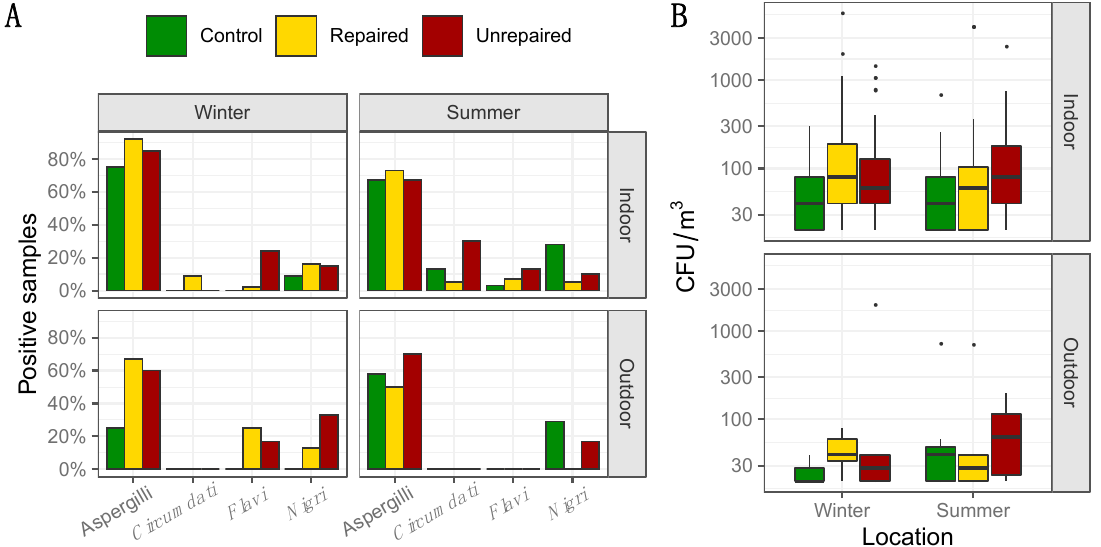
Figure 1. Percentage of positive samples where total airborne Aspergilli, as well as Aspergilli from the sections Circumdati , Flavi, and Nigri, were detected based on analysis of 60 indoor air and 12 outdoor air samples for control and repaired locations and 40 indoor and 10 outdoor air samples for unrepaired locations in each sampling period i.e., winter and summer ( panel A ); Concentration of total Aspergilli (colony-forming units (CFU) / m 3 ) detected in indoor and outdoor air. Each location is represented by a box–whisker plot in a different colour in each sampling period (winter and summer) as specified ( panel B ).